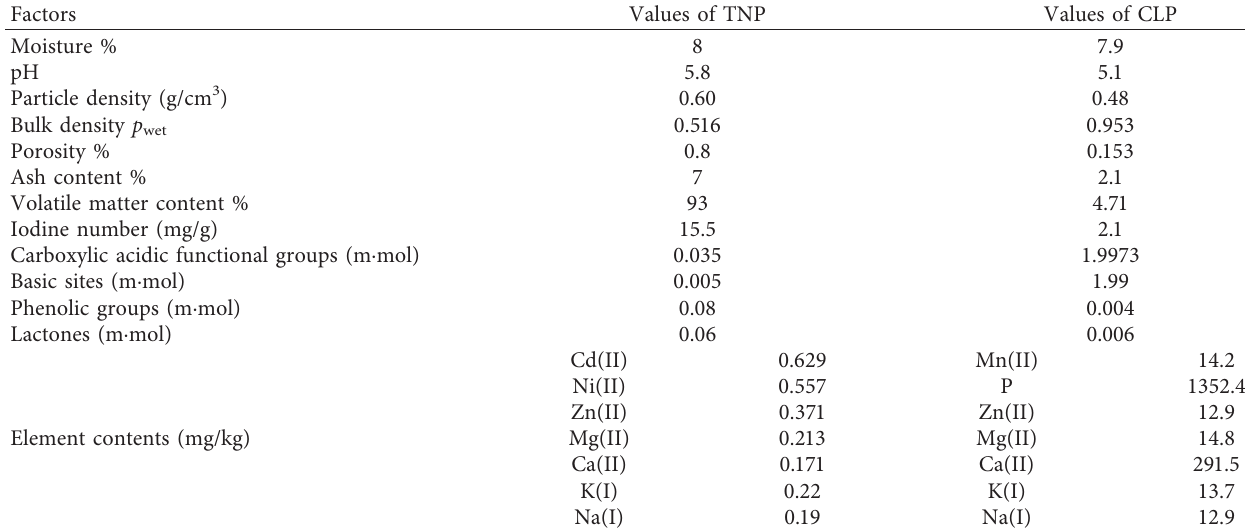
Table 2: Physicochemical analysis of adsorbents